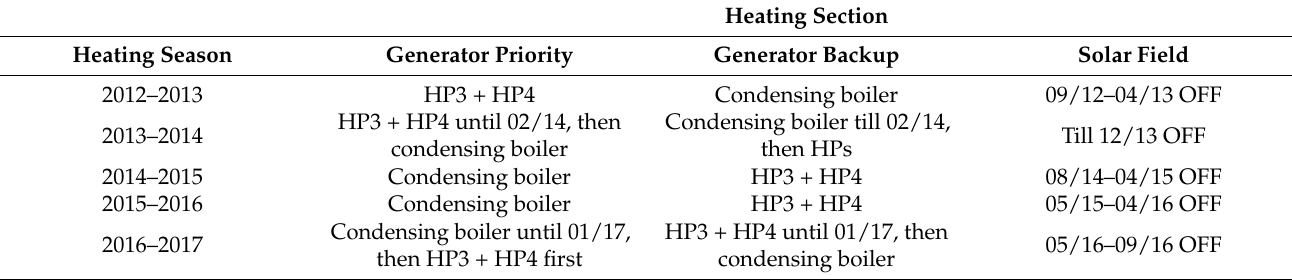
Heating Section